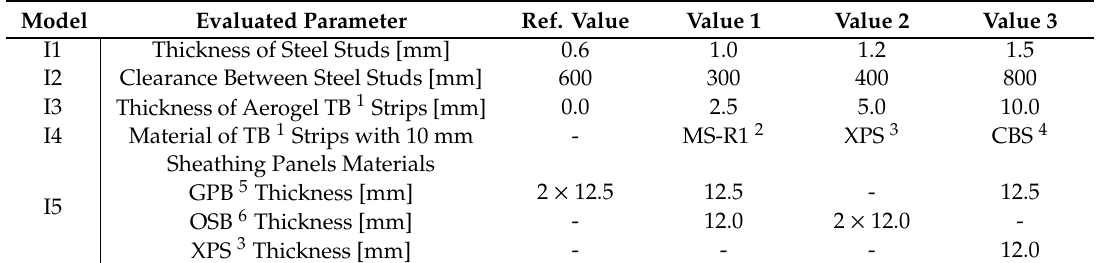
Table 2. Interior partition LSF wall: models and parameter values to be evaluated.